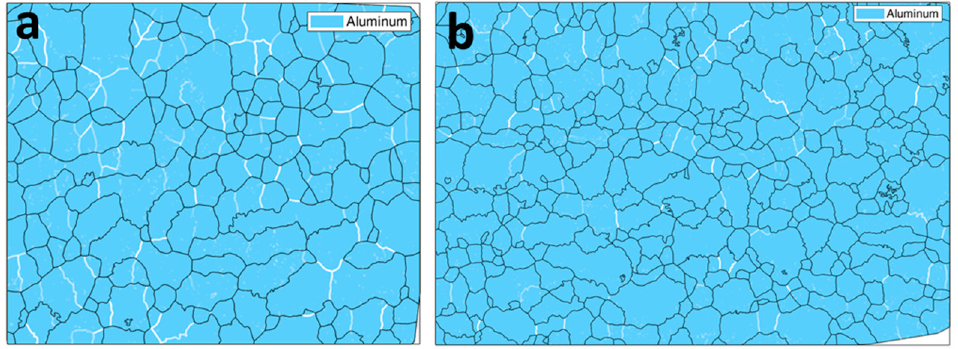
Figure 6. Grain boundary reconstruction by EBSD data showing appearance of LAGBs (white lines with intensities proportional to misorientation) in the microstructure of the gauge section for the UFG 6060 alloy specimen tensile tested with the strain rate of 5 × 10 − 3 s − 1 at ( a ) 150 °C; ( b ) 180 °C.